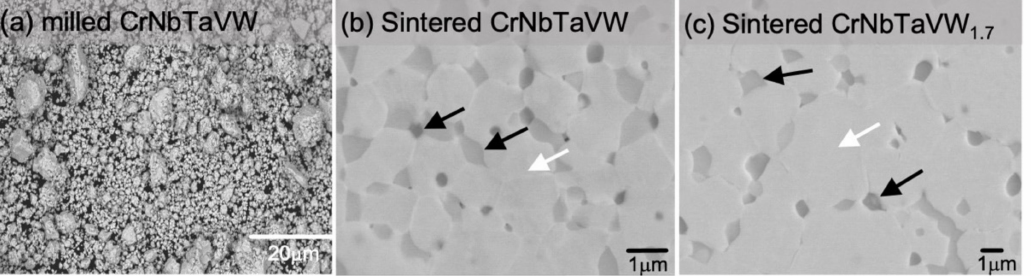
Figure 2. ( a ) BSE image of the milled powder of CrNbTaVW composition and microstructures of sintered ( b ) CrNbTaVW and ( c ) CrNbTaVW 1.7 high entropy alloys. The white arrows in ( b , c ) indicate the presence of the major phase. The black arrows in ( b , c ) indicate the presence of the dark